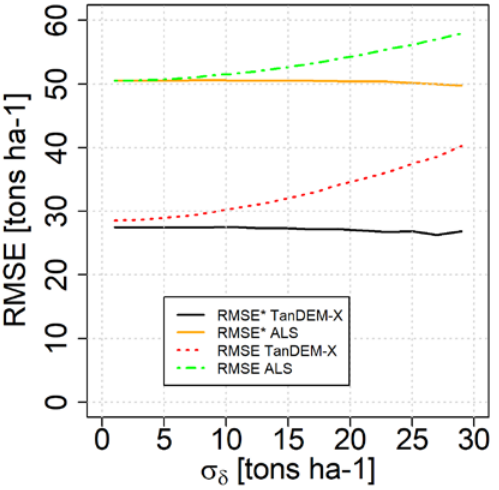
Figure 7. Illustration of how RMSE would change with additional random errors in the field reference data, expressed as σ δ . The values are averages from 1000 simulations.